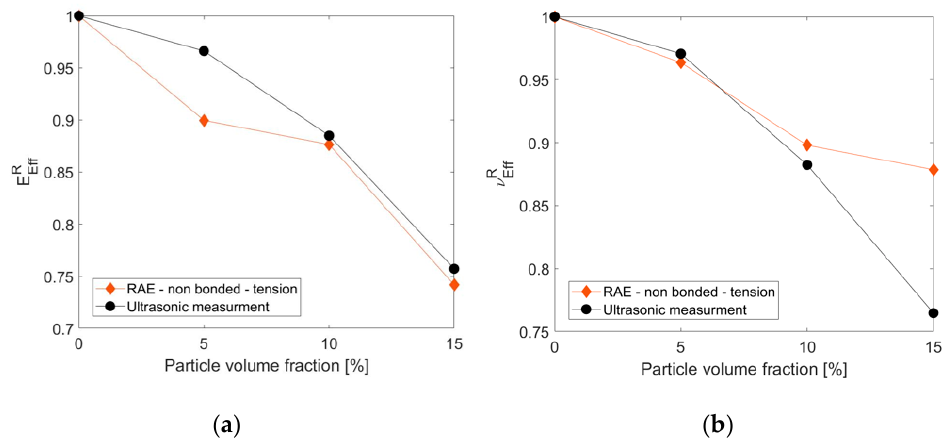
Figure 11. Comparison between measurements (pulse-echo technique) and predicted relative effective elastic modulus ( a ) and Poisson’s ratio ( b ) (RAE computations under tension loading) for different particle volume fractions.